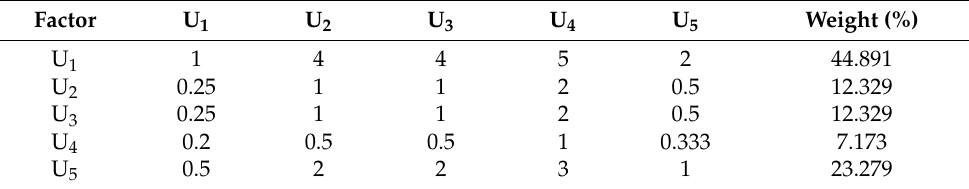
Table 4. Judgment matrix of SZSOJ’s first-level evaluation factors.